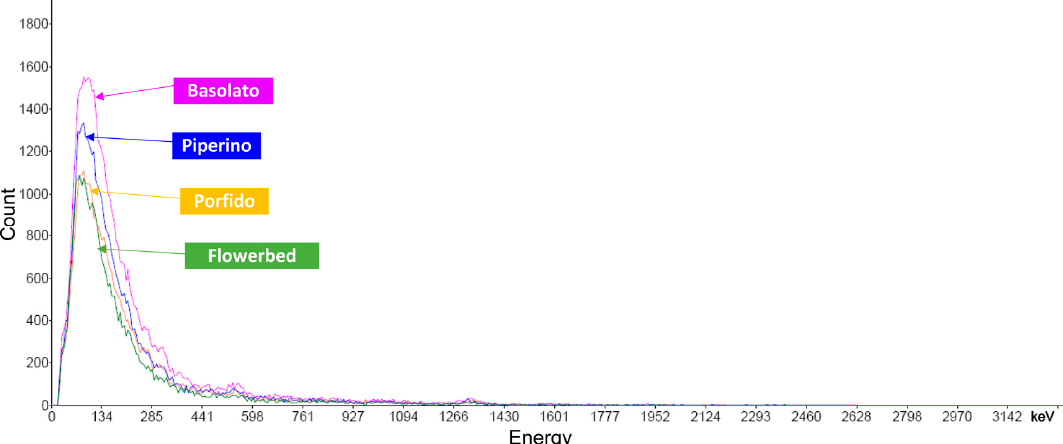
Figure 5. Spectra of different flooring materials in B. Longo Square. It is interesting to notice how igneous ( basolato ) or volcano-sedimentary ( piperino ) rocks are easily recognizable, especially if we consider some energy intervals in the left part of the graph.